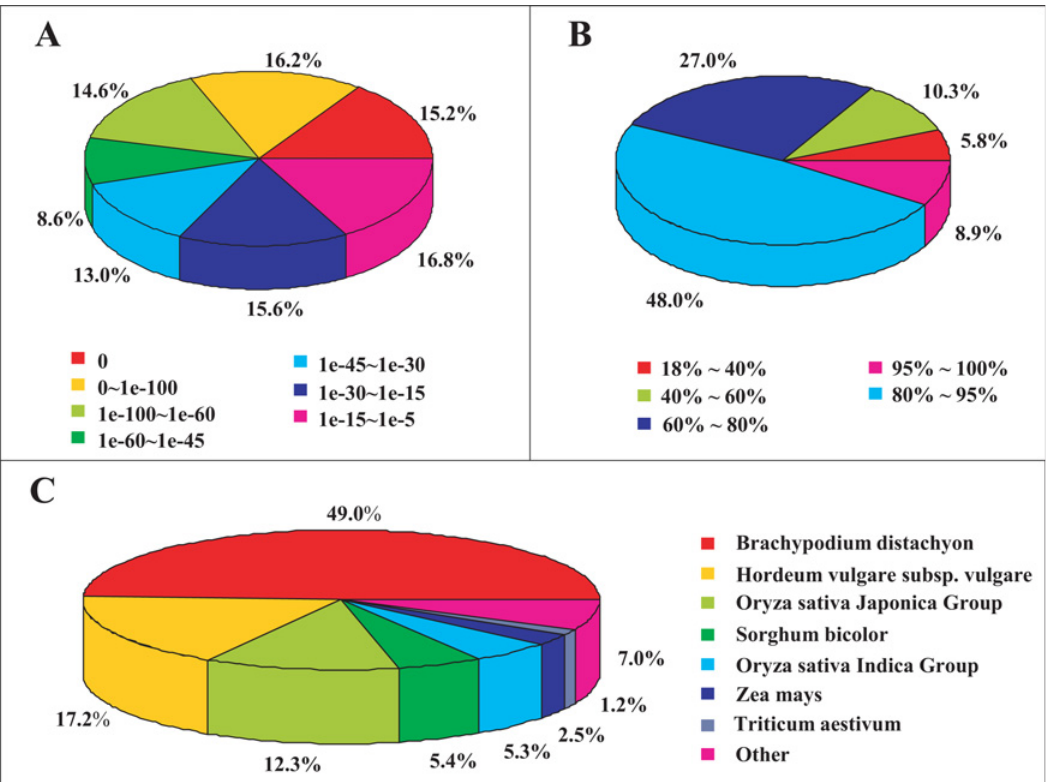
Fig 2. Unigene homology searches against the nr database. (A) The proportional frequency of the E-value distribution. (B) The proportional frequency of the sequence similarity distribution. (C) The proportional species distribution of S . grandis among other plant